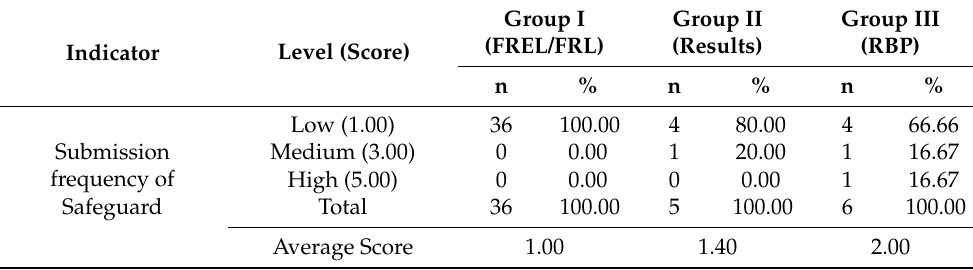
Table 7. Results of MRV capacity evaluation on